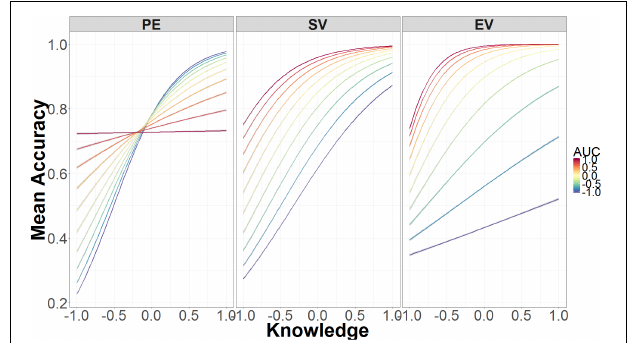
FIGURE 8 | Mean accuracy as a function of the interaction between AUC, security knowledge, and authentication level. The data on the x-axis are normalized and range from 2 SD below the mean ( − 1.00) to 2 SD above the mean ( + 1.00).